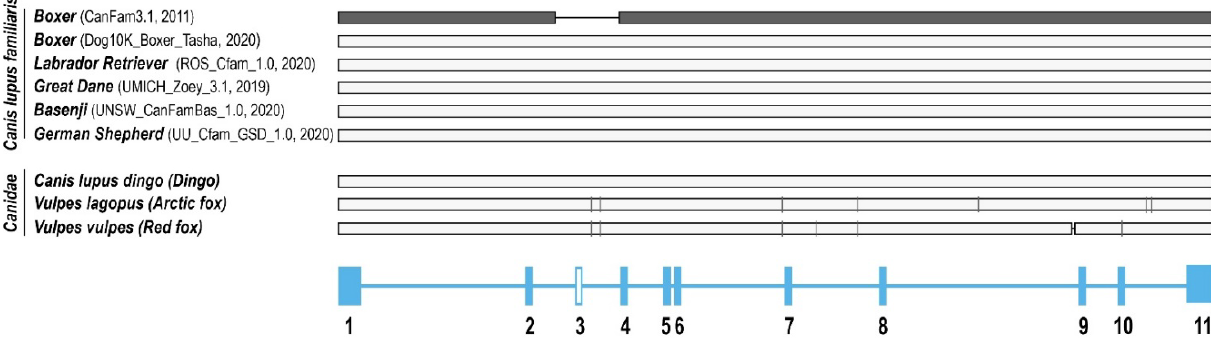
Figure 9. Alignment of dog OCT1 against different canine genomic DNA sequences. The dog OCT1 genomic sequence from the CanFam3.1 assembly (dark grey) has a 2153 bp gap in the exon 3 region compared with more recent dog genome assemblies that are identical to our experimentally determined dog OCT1 sequence. The dog OCT1 exon-intron structure is shown below for orientation.